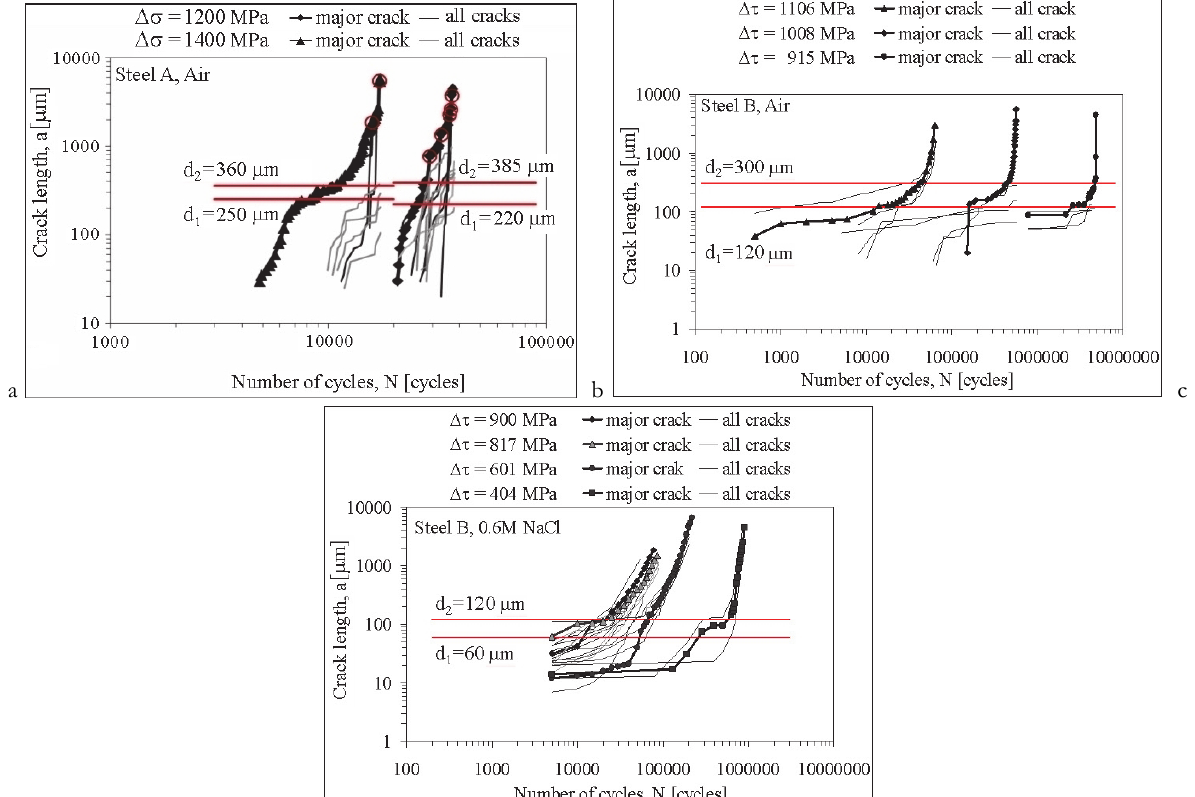
Figure 1: Plots “Crack length, a – Numbers of cycles, N ” and lines d 1 and d 2 defining PSC regime for Steels: (a) A - RBF; (b) & (c) B –